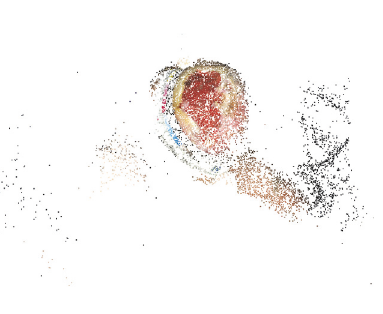
Figure 4: The obtained 3D point cloud from the SfM